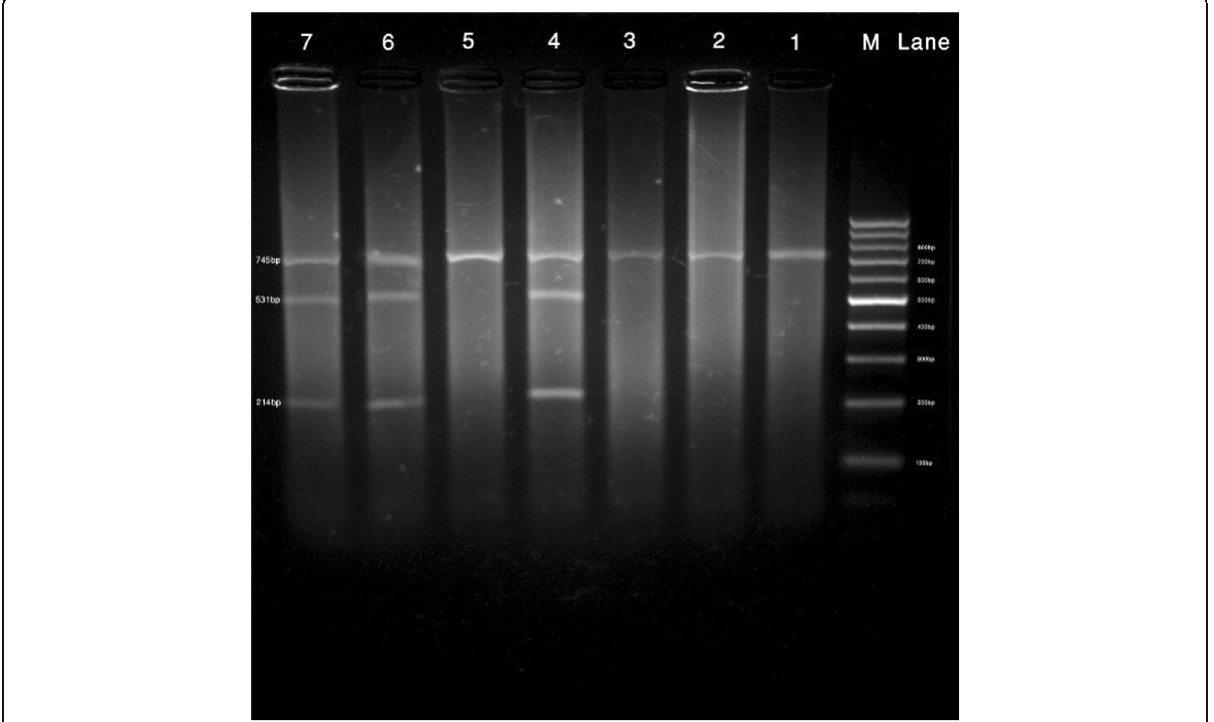
Fig. 2 Representative gel picture showing the PCR-RFLP analysis of ApaI VDR gene polymorphism on ethidium bromide-stained 2% agarose gel. M, marker (100 bp DNA ladder); lanes 4, 6, and 7 represent heterozygous polymorphism (CA genotype; 745, 531, and 214 bp bands); lanes 1, 2, 3, and 5 represent no polymorphism (AA genotype; 745 bp